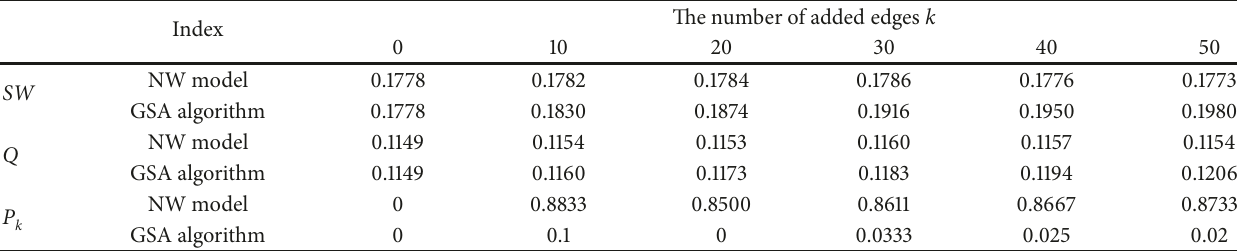
Table 2: Comparison between the NW model and the GSA